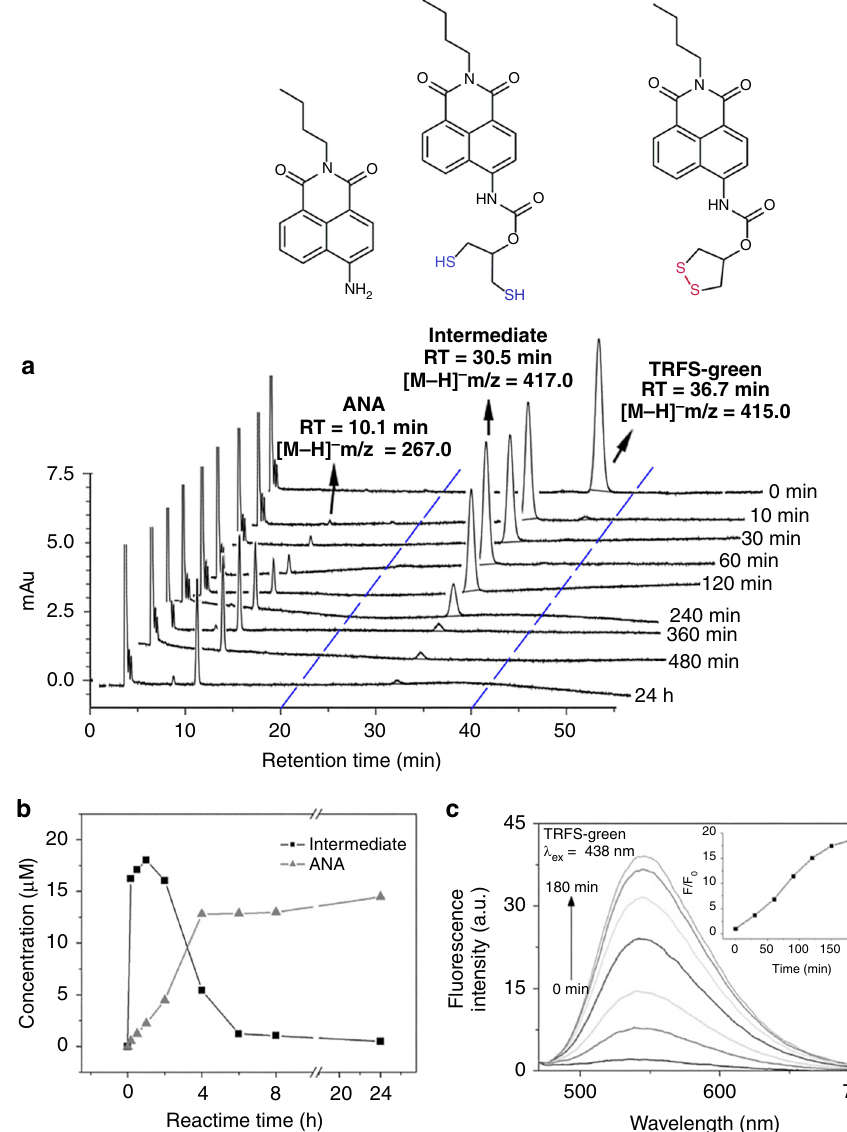
Fig. 2 Stepwise activation of TRFS-green by TCEP. a TRFS-green (20 μ M) was incubated with TCEP (1 mM) in TE buffer (50 mM Tris-HCl, 1mM EDTA, pH 7.4) at 37 °C for 24 h. The reaction mixture was analyzed by HPLC, and the quanti fi cation of intermediate and ANA was shown in ( b ). c Time- dependent fl uorescence changes of TRFS-green (10 μ M) in the presence of TCEP (1 mM) in TE buffer at 37 °C. The inset shows the time-dependent changes of emission at 538 nm ( λ ex = 438 nm). Source data are provided as a Source Data fi le.Source Data fi